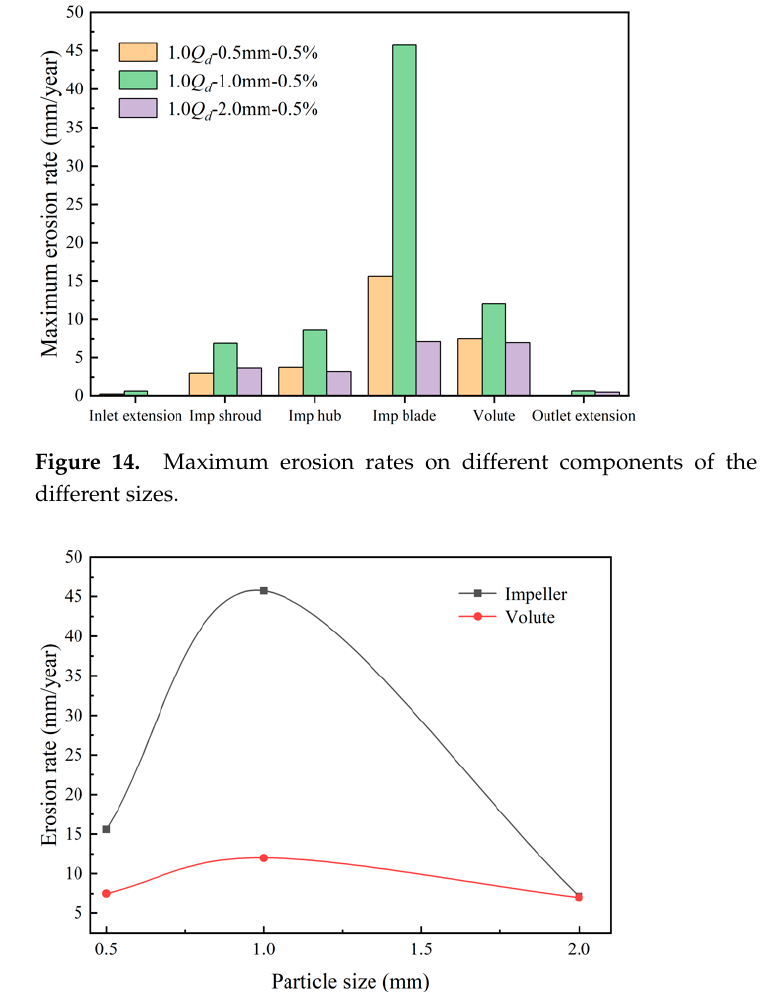
Figure 15. Curves of erosion rates on the impeller blade and volute with varying particle sizes.